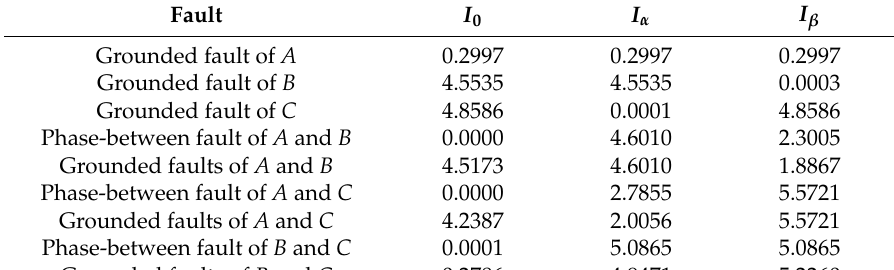
Table 4. Maximum wavelet coefficients I 0 , I α , and I β of the different faults.